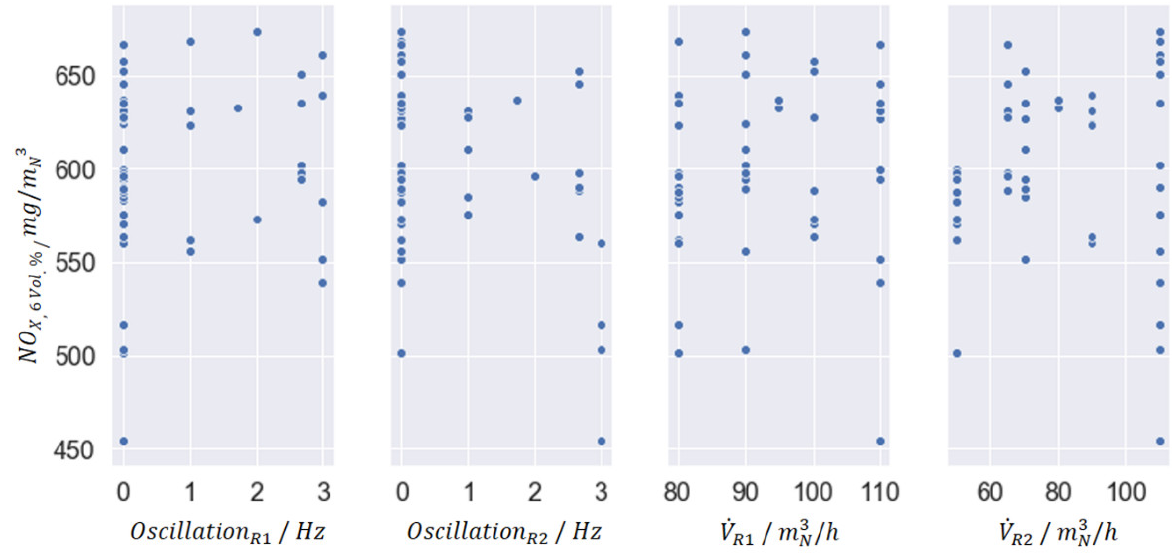
Figure 6. Results from oscillation and air flow in R1 and R2.